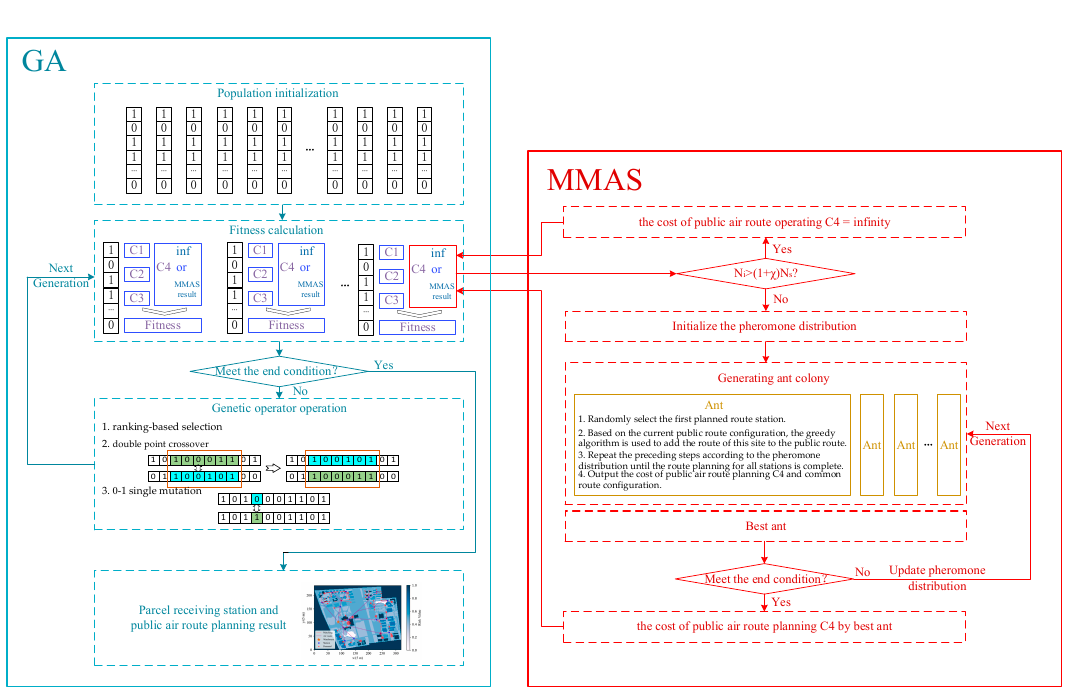
Figure 7. GA-MMAS algorithm flow chart.